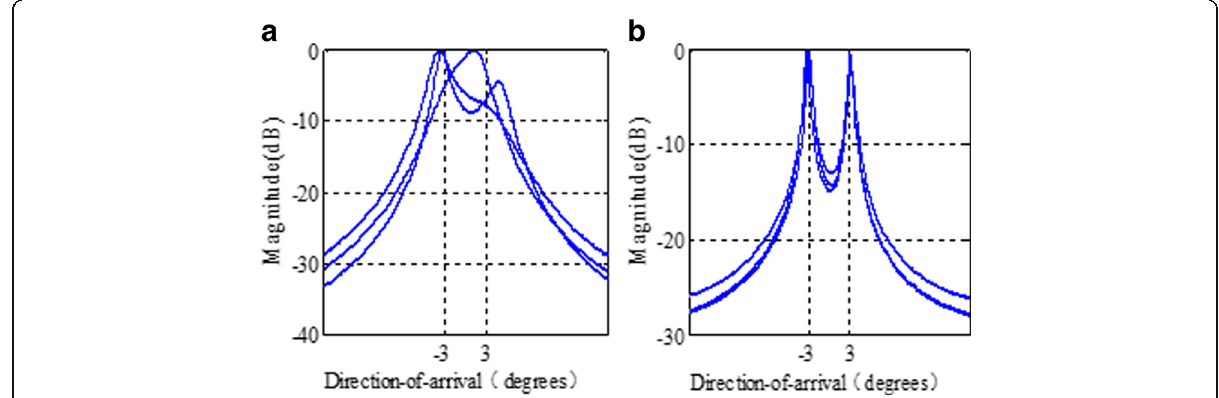
Fig. 4 Spatial spectrum: a Spatial spectrum of TF MUSIC algorithm. b Spatial spectrum of PTF MUSIC